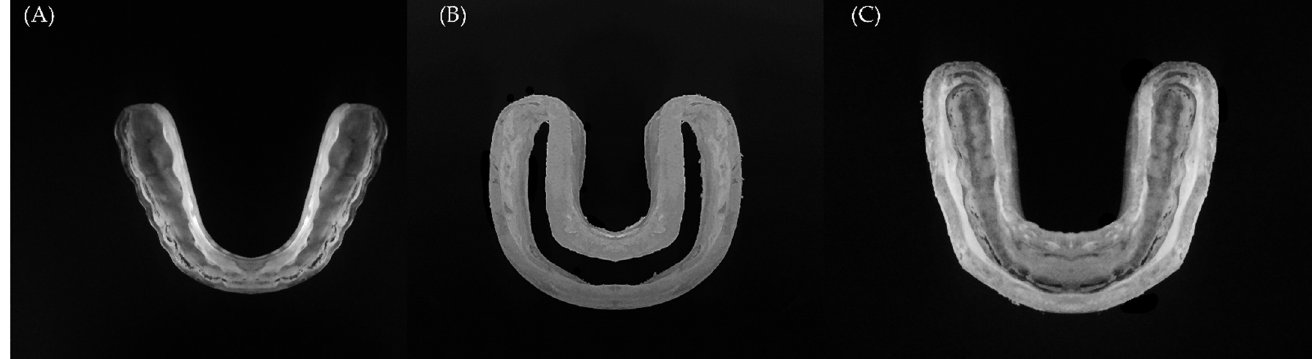
Figure 2. Hybrid occlusal splint mouthguard components. ( A ) Rigid inner portion made of polycarbonate, ( B ) Axial flexible flanges made of ethylene vinyl acetate and, ( C ) the final modulated appliance assembled as the HMG.